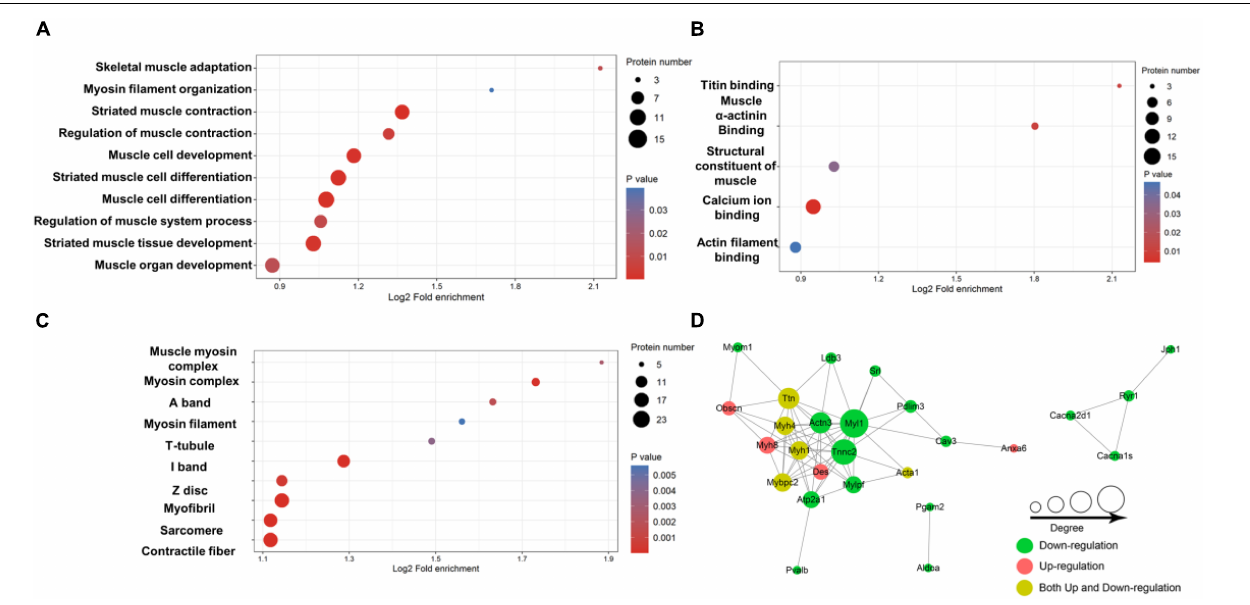
FIGURE 4 | Enrichment analysis of the lysine-acetylated proteins. Enrichment based on GO annotation in terms of biological process (A) , molecular function (B) , and cellular component (C) . (D) Protein–protein interaction network for acetylated proteins. The nodes represent proteins, and their colors represent the upregulation or downregulation of these proteins; green means downregulation (change ratio < 0.83), red means upregulation (change ratio > 1.20), and yellow means both upregulation and downregulation. The size of each node represents the number of directed edges.